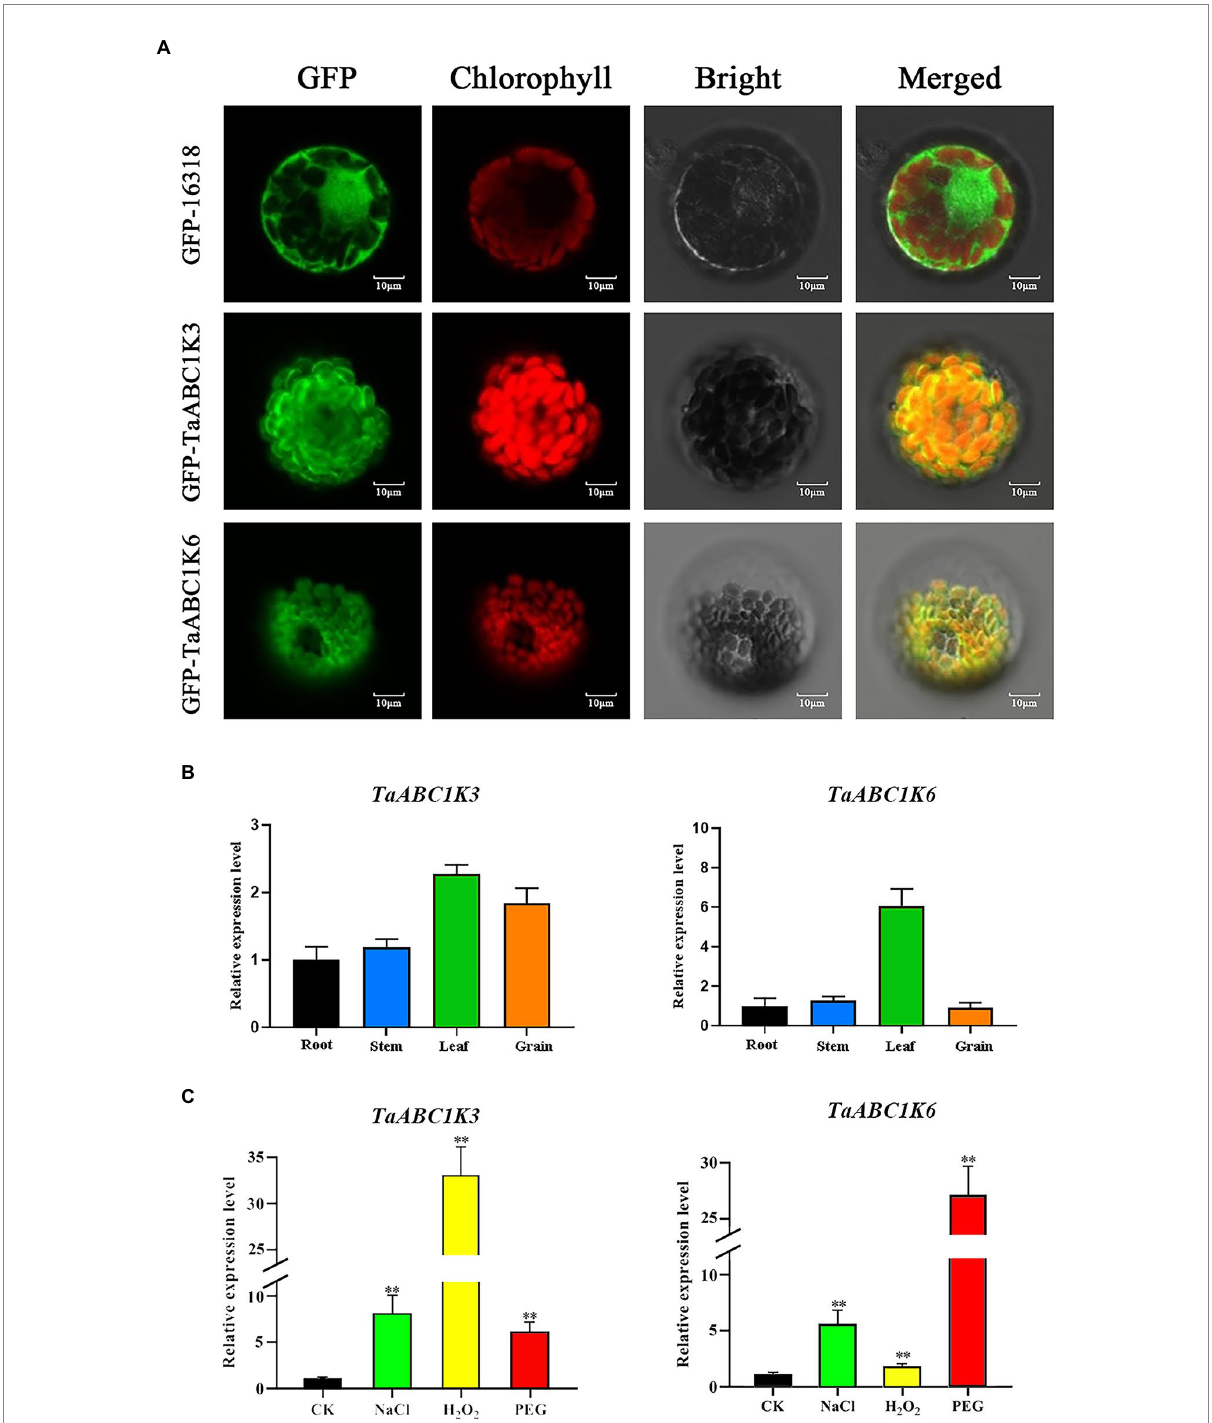
FIGURE 5 Subcellular localization and RT-qPCR analysis of TaABC1K3 and TaABC1K6 . (A) Subcellular localization of TaABC1K3 and TaABC1K6. GFP was induced fluorescence, chlorophyll is chloroplast autofluorescence. (B) RT-qPCR analysis of TaABC1K3 and TaABC1K6 genes in wheat different tissues. (C) RT-qPCR analysis of TaABC1K3 and TaABC1K6 genes under abiotic stresses. Statistically significant differences between control group and treatment group were calculated by an independent Student’s t -tests: ** p <